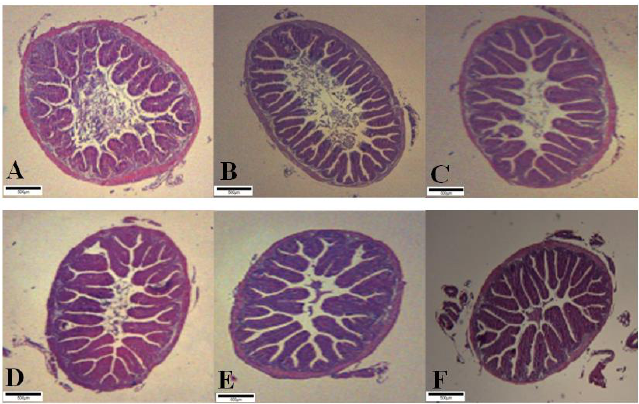
Figure 1. Histological sections of juvenile Nile tilapia intestine fed the experimental diets for 8 weeks. A-CON, basal diet; B-OTC, oxytetracycline; oxytetracycline at 4 g / kg; C-BS 7 , Bacillus subtilis at 1 × 10 7 CFU / g; D- BS 8 , Bacillus subtilis at 1 × 10 8 CFU / g; E- LL 7 , Lactococcus lactis at 1 × 10 7 CFU / g; F-LL 7 , Lactococcus lactis at 1 × 10 8 CFU / g. (Scale bar = 100 µ m; Original magnification × 4).